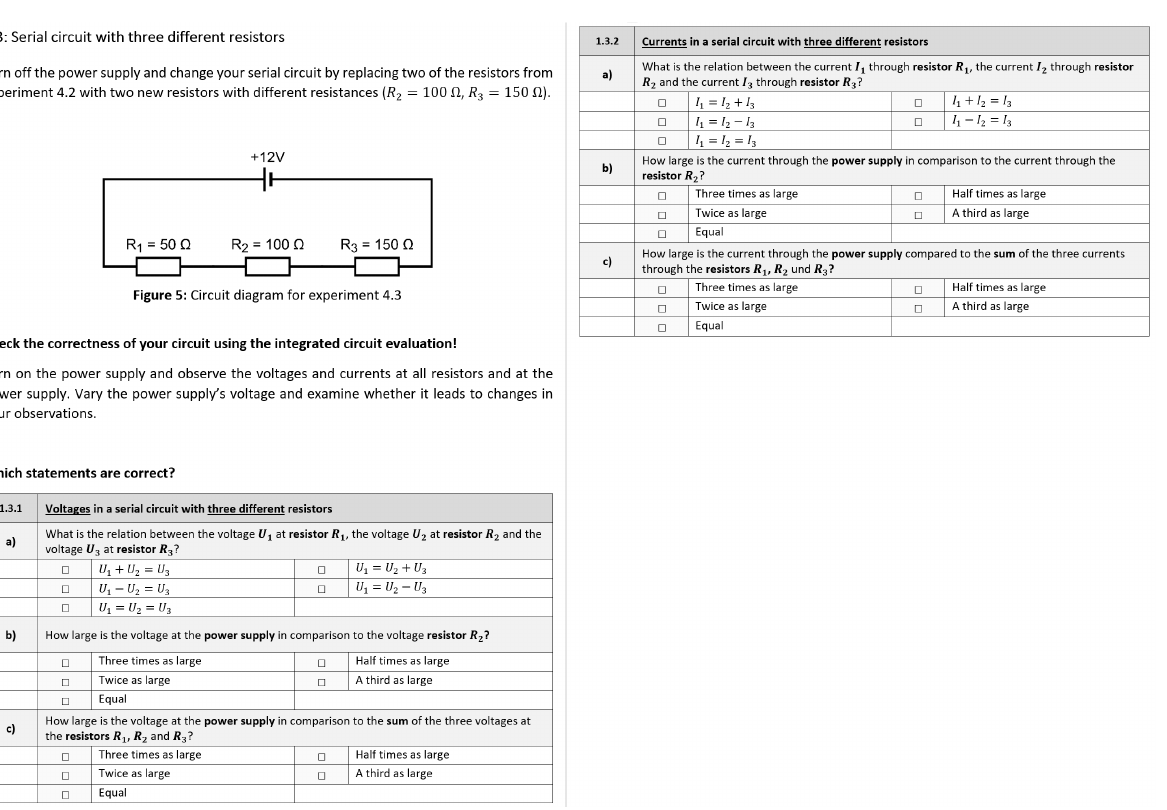
Figure 10. Example task from the study examining a serial circuit consisting of three different resistors (translated for this